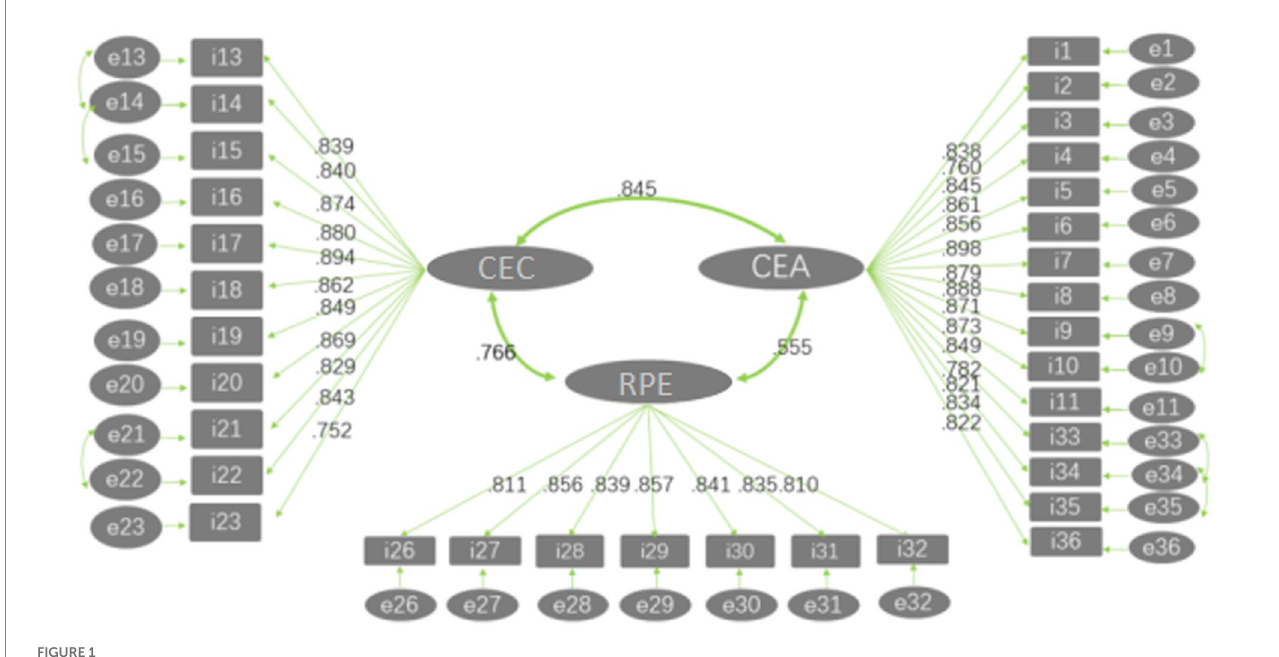
FIGURE 1 Structure of the scale.